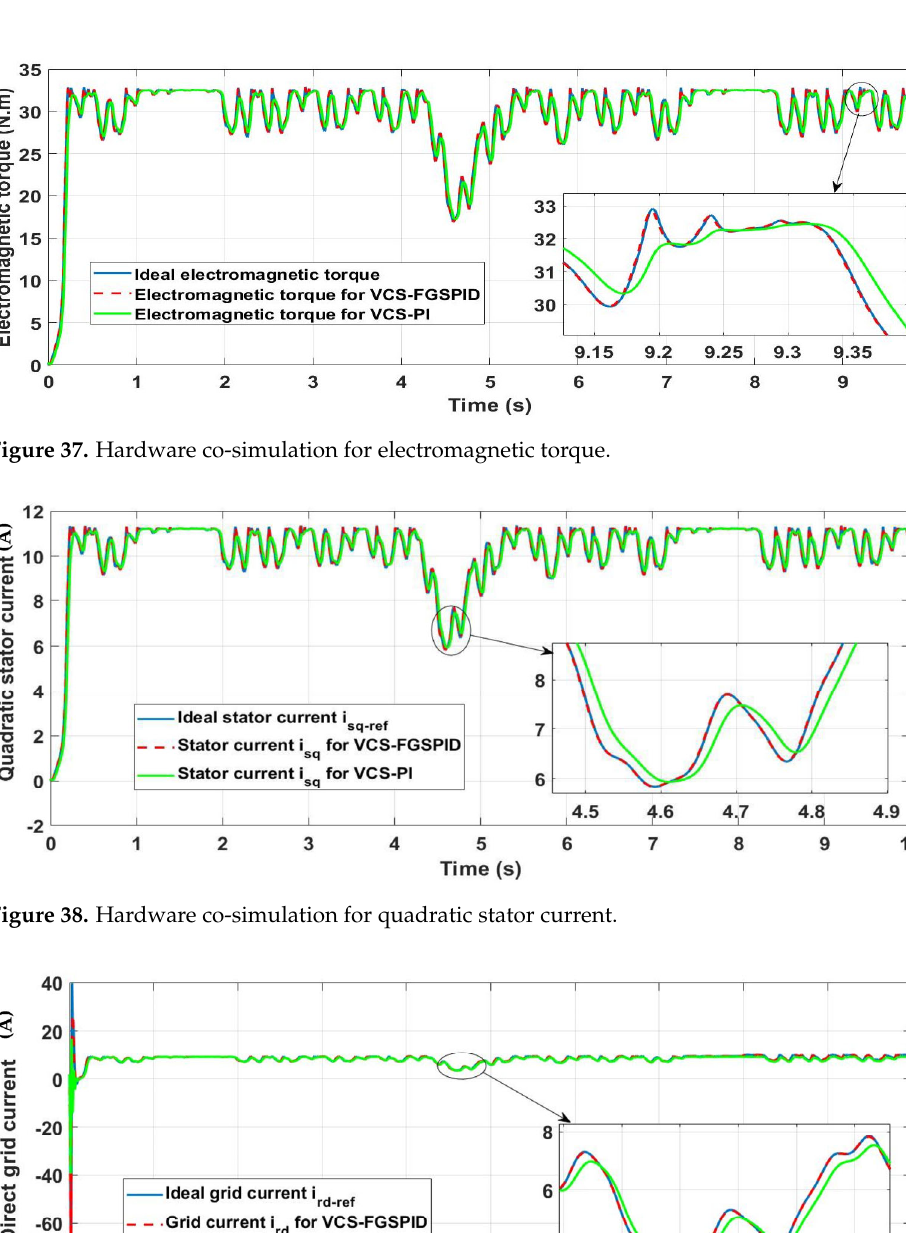
Figure 36. Hardware co-simulation for VCS-FGS-PID controllers.